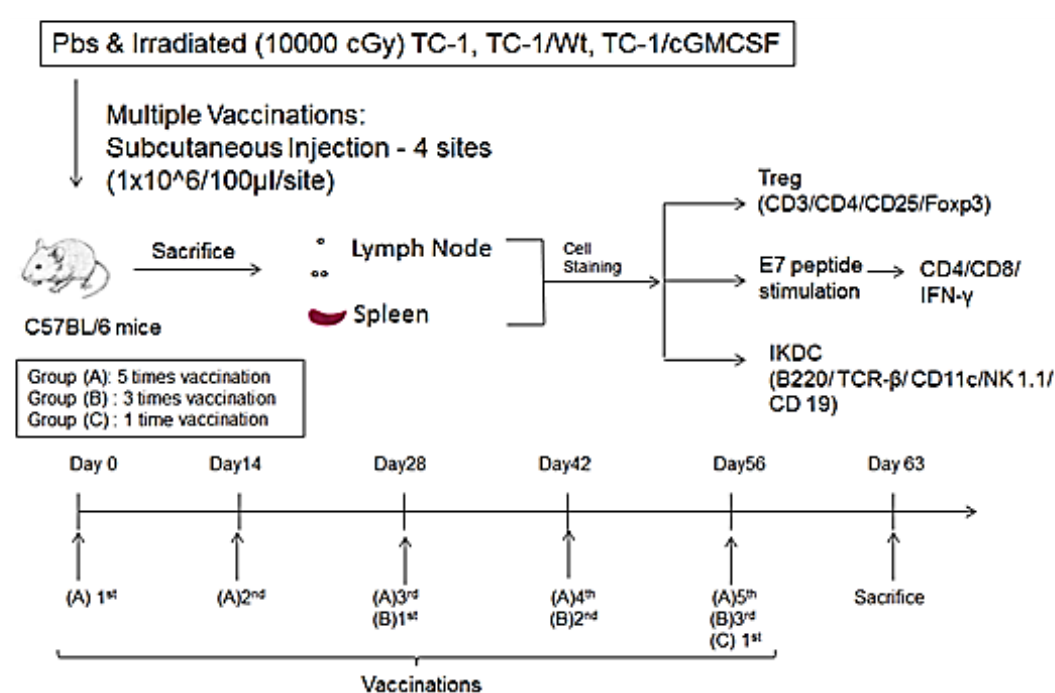
Figure A1. Mice immunization schedule. Mice ( n = 5–10) vaccinated subcutaneously with one, three, or five doses of irradiated TC-1/cGMCSF vaccine. Seven days after the last vaccination, spleens and lymph nodes from the mice were collected and analyzed by flow cytometry for CD4 + , CD8 + , T-Regs, IKDCs, and IFN- γ. Mice were vaccinated once every two weeks.